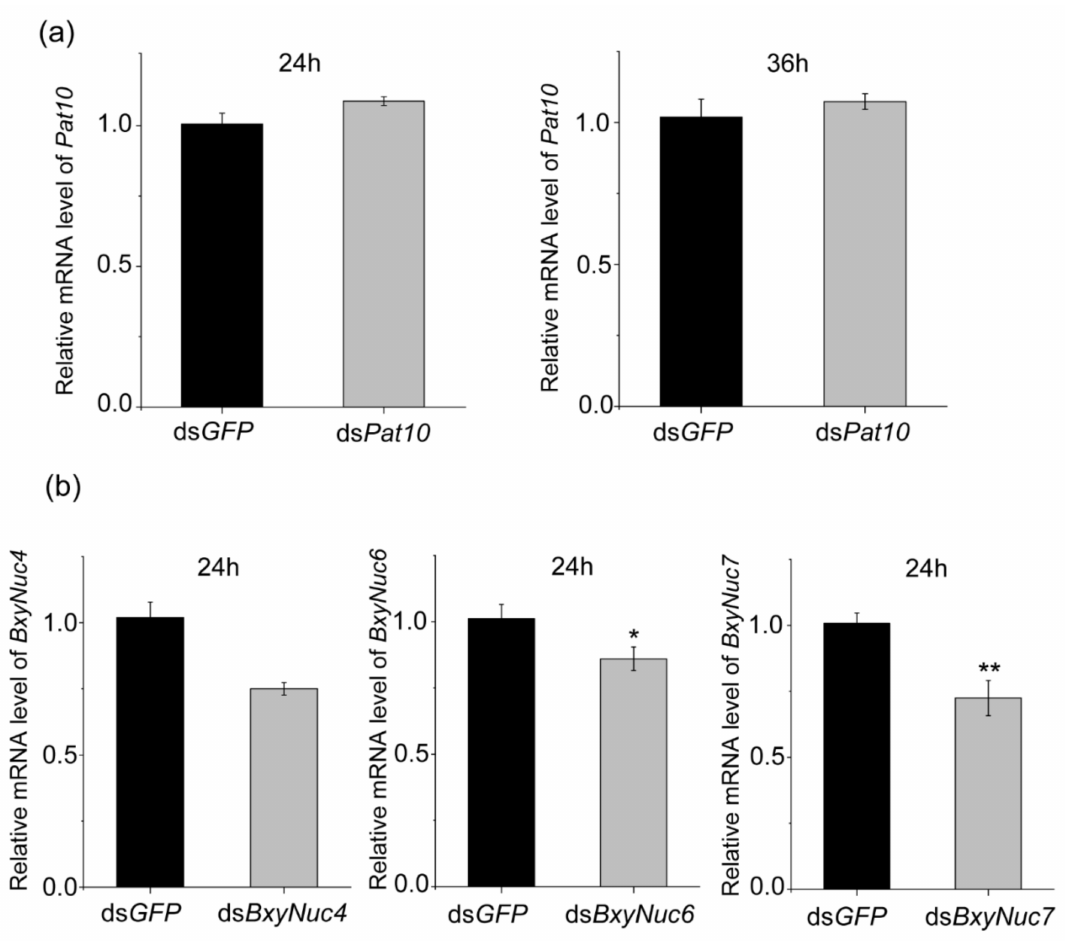
Figure 6. The relative expression level of Pat10 and nucleases genes. ( a ) The relative mRNA level of Pat10 after interfering for 24 and 36 h. ( b ) The relative mRNA level of BxyNuc4 / BxyNuc6 / BxyNuc7 after interfering for 24 h. Gene expression differences between two groups were calculated using the independent samples t test. Data are presented as mean ± SE, ** p < 0.01; * p <